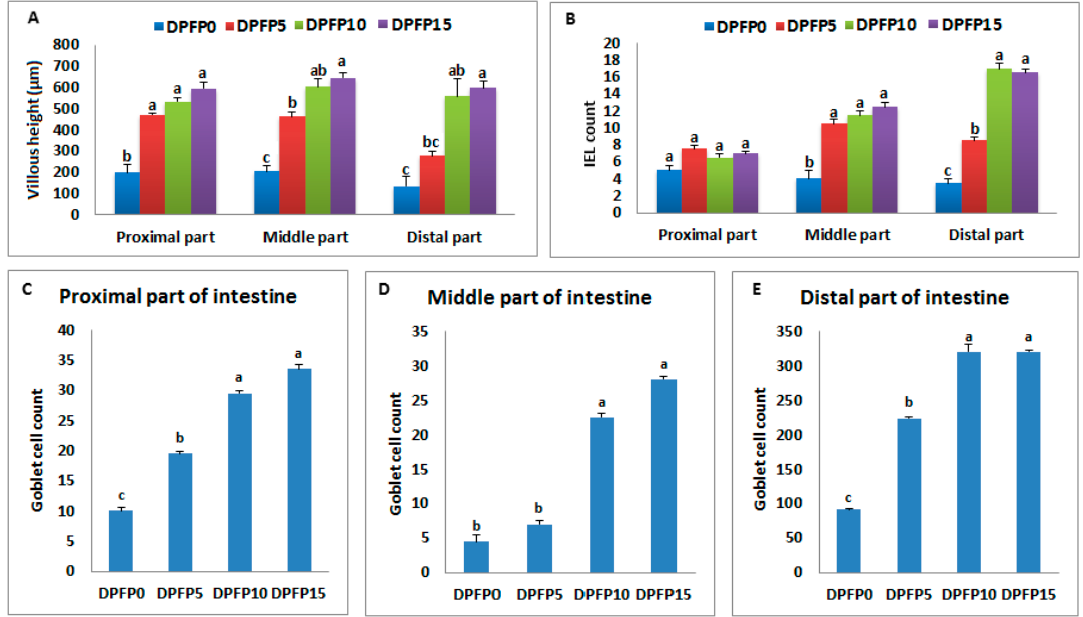
Figure 1. The average villous height (µm) ( A ), intraepithelial lymphocytes count, intraepithelial lymphocytes (IEL) ( B ), and goblet cell count ( C – E ) of intestinal parts (proximal, middle, and distal) of African catfish fed on DPFP-enriched diets at 0, 5, 10, and 15 g kg − 1 (DPFP0, DPFP5, DPFP10, and DPFP15), respectively, for 10 weeks. The groups with di ff erent superscript di ff er significantly ( p < 0.05). Data were expressed as Mean ± SE, n =